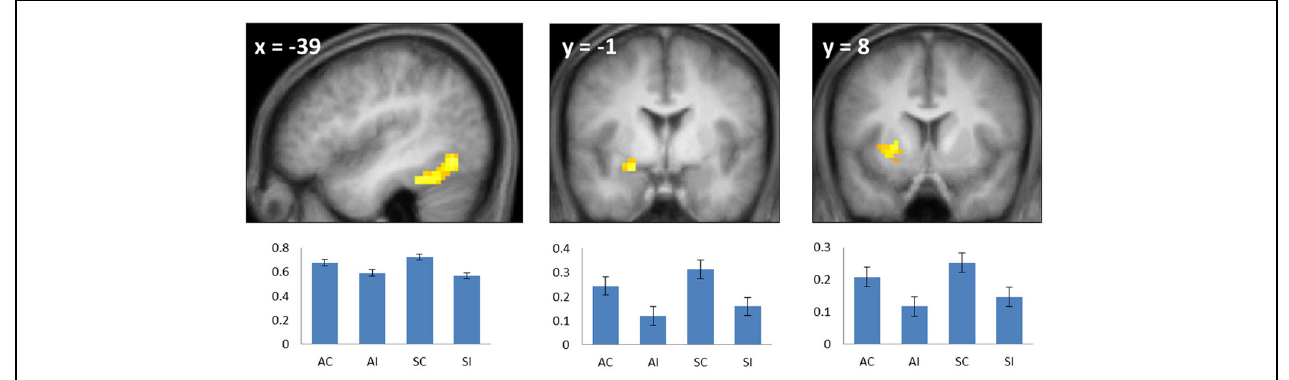
T1-weighted anatomical image (note—in this and subsequent figures, the mean image is derived from only 19 of the 20 included subjects, because of the corruption of one subject’s anatomical data). Error bars here and in the following figures signify the standard error of the mean derived from the error term of the one-way ANOVA (Loftus and Masson, 1994).